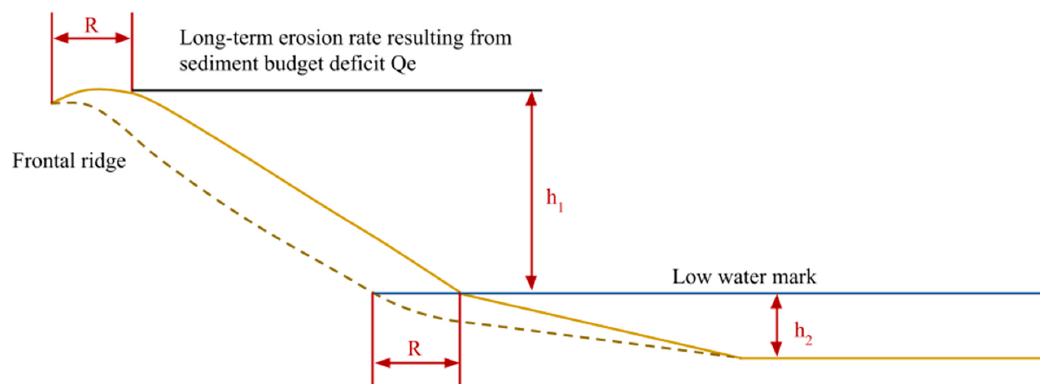
Figure 2. Relationship between sand volume loss and recession. Table 2. Total sand volume lost from Gold Coast beaches, 1960–2000 (Source: [47]). Total Cumulative Volume of Sand Withheld from Period Southern Gold Coast at Letitia Spit by Tweed River Training Walls (m 3 )